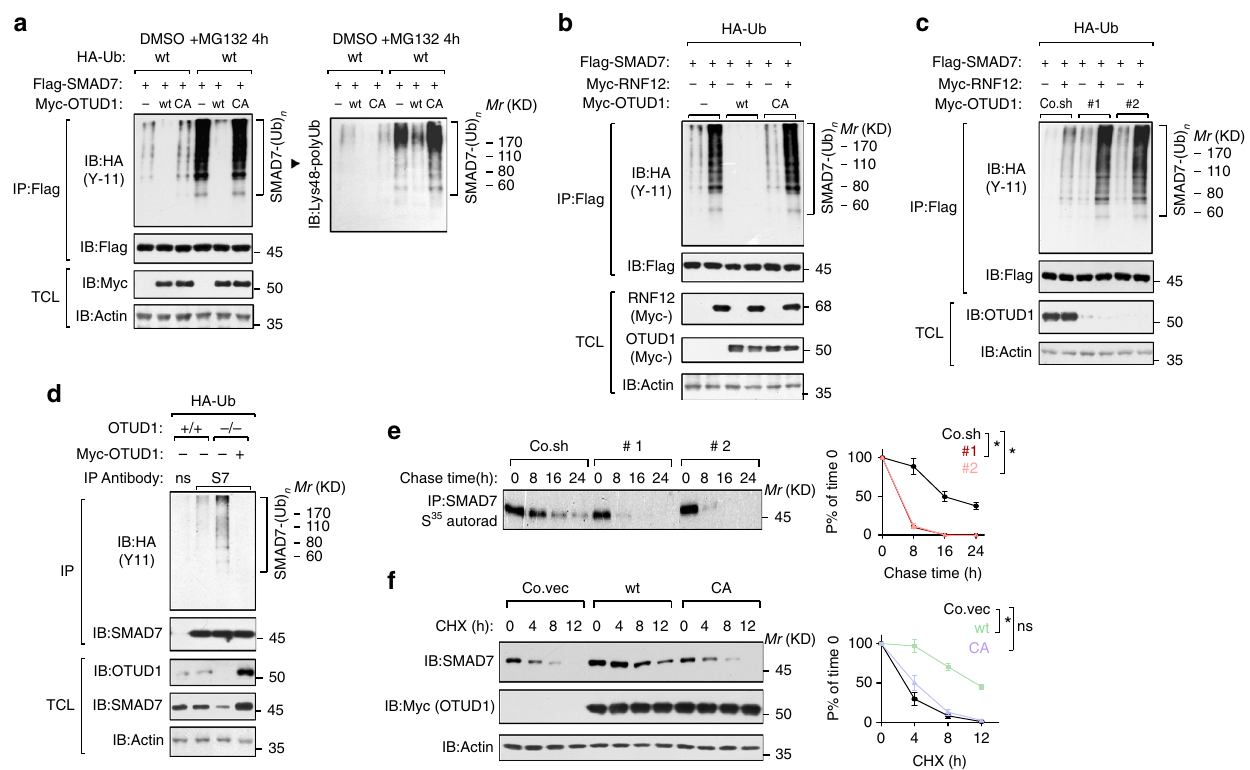
Fig. 5 OTUD1 deubiquitinates SMAD7 in vivo and sustains SMAD7 stability. a IB of total cell lysate (TCL) and immunoprecipitates derived from HEK293T cells transfected with HA-Ub, Flag-SMAD7, Myc-OTUD1-wt/CA and treated with control DMSO or MG132 (5 μ M for 4 h) as indicated. b , c IB of TCL and immunoprecipitates derived from HEK293T stably expressing HA-Ub and transfected with Flag-SMAD7, Myc-RNF12, and Myc-OTUD1-wt/CA ( b ) or depleted for OTUD1 with shRNA (#1 and #2) c as indicated. Poly-ubiquitinated SMAD7 was immunoprecipitated with anti-Flag M2 beads and analyzed by IB with anti-HA-Ub antibody. d IB of TCL and immunoprecipitates derived from OTUD1 + / + and OTUD1 − / − HEK293T cells stably expressing HA-Ub and restored with or without Myc-OTUD1 expression plasmid. Endogenous poly-ubiquitinated SMAD7 was immunoprecipitated with anti-SMAD7 (S7) antibody and immunoblotted with anti-HA-Ub antibodies. e [ 35 S]-methionine labeling and pulse-chase studies of SMAD7 in control (Co.sh) and OTUD1-depleted PC3 (#1 and #2). The amount of immunoprecipitated labeled protein after the chase was expressed as the percentage of that at the beginning of the chase (time 0) and shown in the right panel. Results are shown as means ± SD of two independent sets of experiments in duplicate. f IB of lysates derived from PC3 cells stably expressing empty vector (Co.vec), Myc-OTUD1-wt or OTUD1-CA and treated with cycloheximide (CHX, 20 μ g/ml) at the indicated time points. Actin was analyzed as an internal loading control. Quanti fi cation of the band intensities was shown in the right panel. Band intensity was normalized to the t = 0 controls. Results are shown as means ± SD of three independent sets of experiments. * p < 0.05 (two-tailed Student ′ s t -test e , f